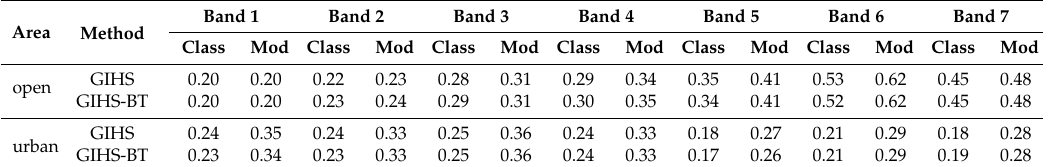
Table 4. Correlation coefficient for the fusion of Landsat 8 OLI and WorldView-2 imagery data using the classical (class) and modified (mod) approach.